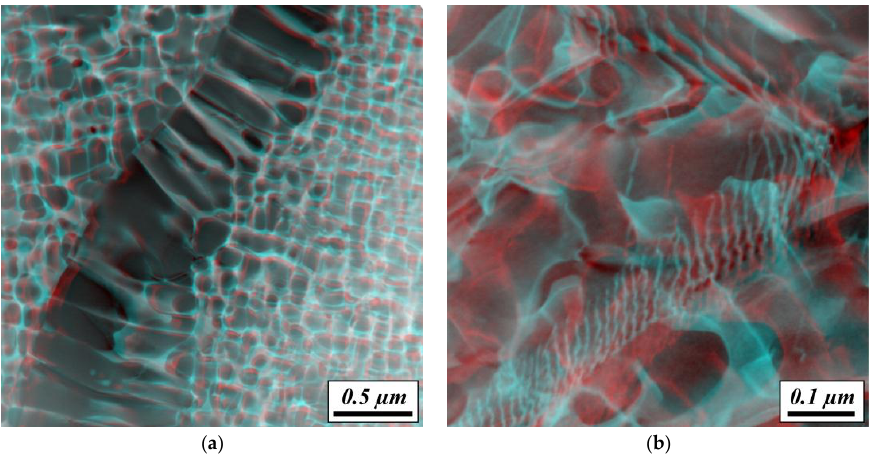
Figure 14. Anaglyphs showing grain boundary microstructures in SEBM Specimen B: ( a ) high angle grain boundary with coarse γ/γ′ microstructure; and ( b ) low angle grain boundaries representing dislocation networks. For details see text. (for 3D impression use colored glasses: )